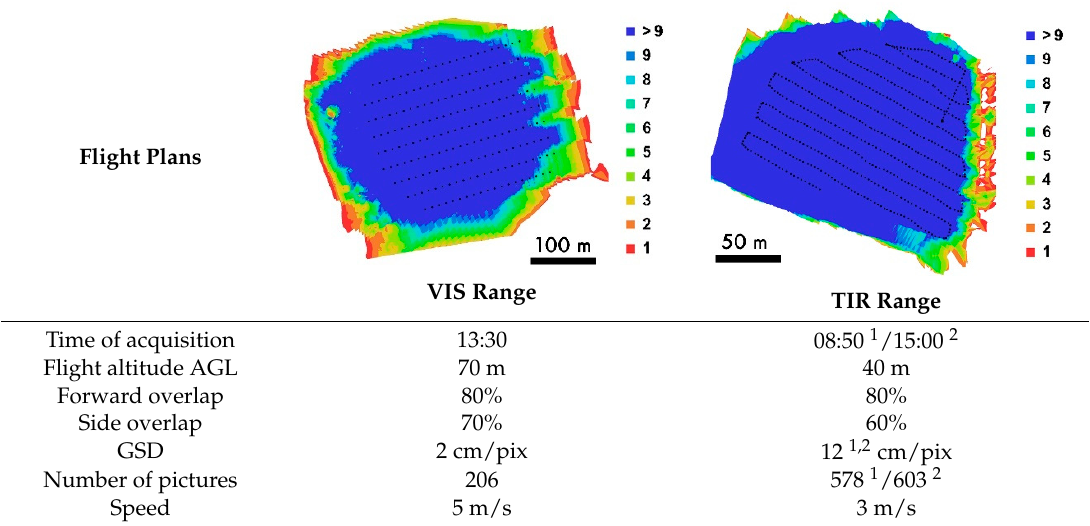
Table 3. The three flight plans in the visible (VIS) and Thermal InfraRed (TIR) ranges. The pictures represent camera locations (black dots) of each swipe and image overlap (colors).